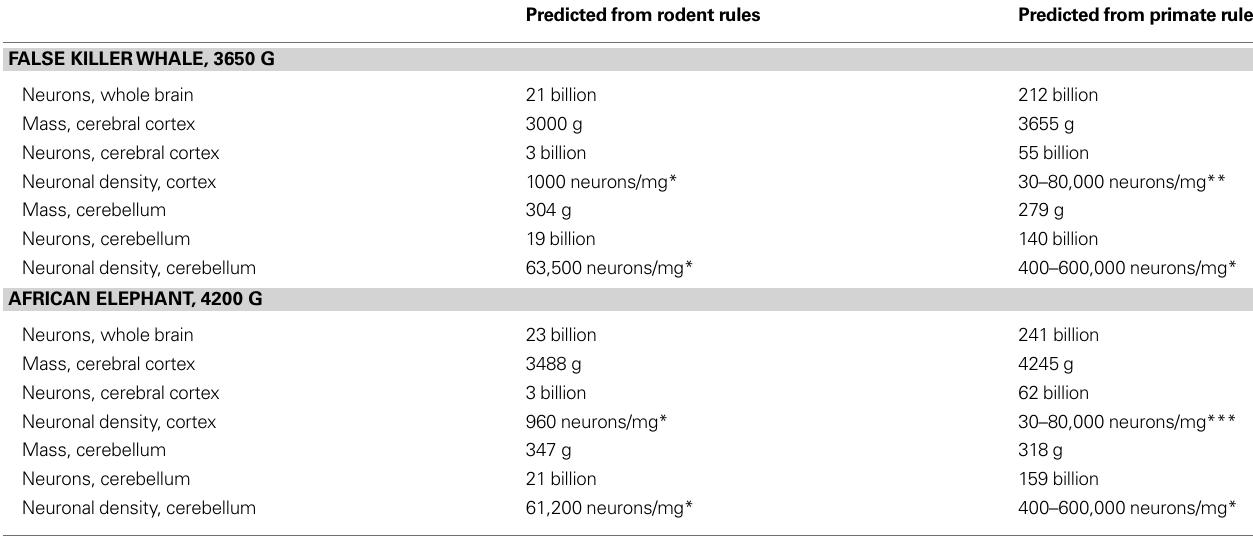
Table 3 | Predicted cellular composition of whale and elephant brains if they scaled according to rodent or primate cellular scaling